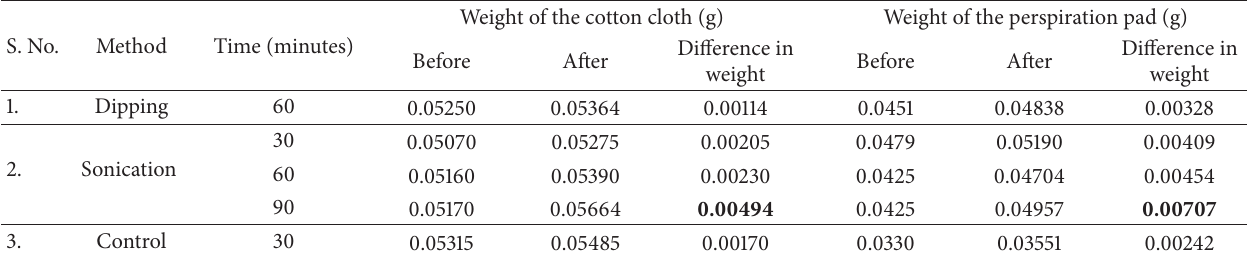
Table 1: Comparative results of methods used in the fabrication of AgNPs on the cotton cloth and perspiration pad samples. S. No.